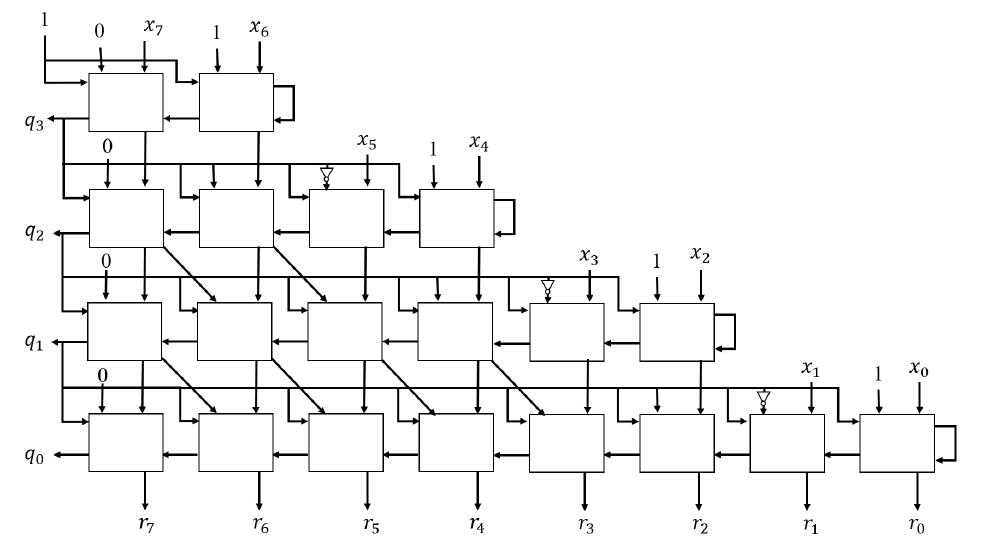
Figure 1. An example of an 8-bit non-restoring square root array